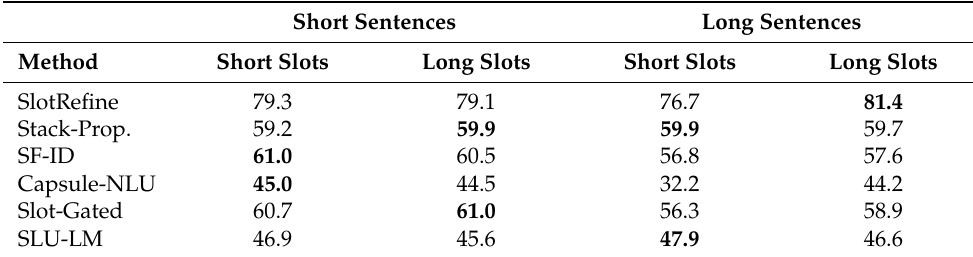
Table 5. Results for intent detection with joint NLU (in %).